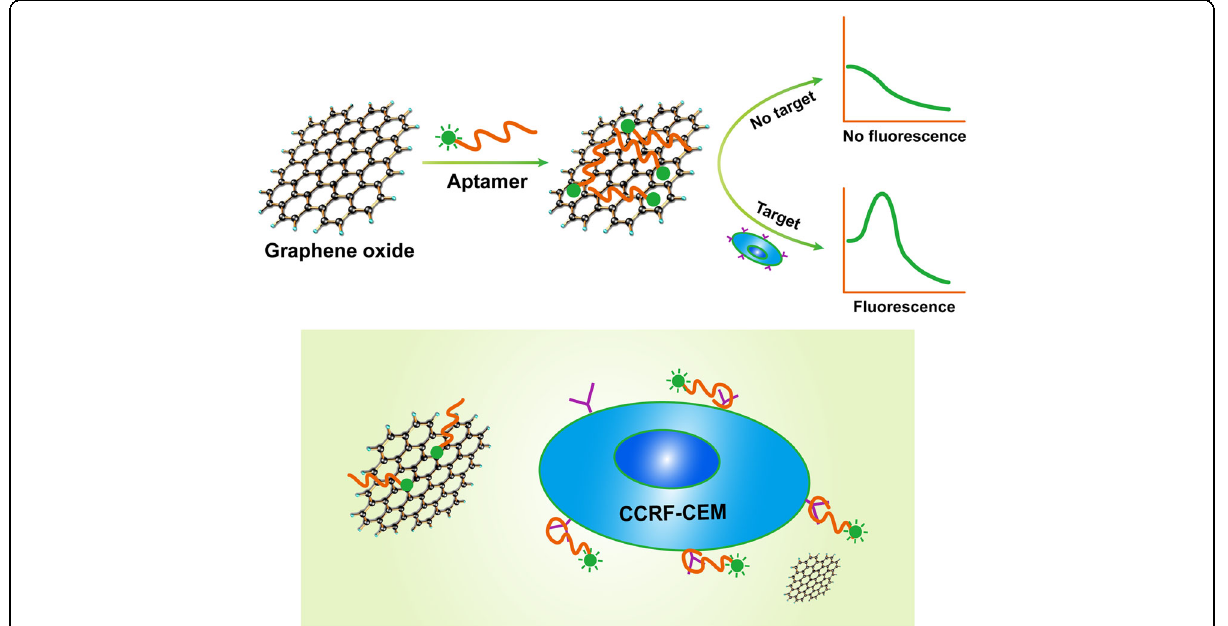
Fig. 1 Schematic illustration of GO-apt fluorescent aptasensor for detection of CCRF-CEM